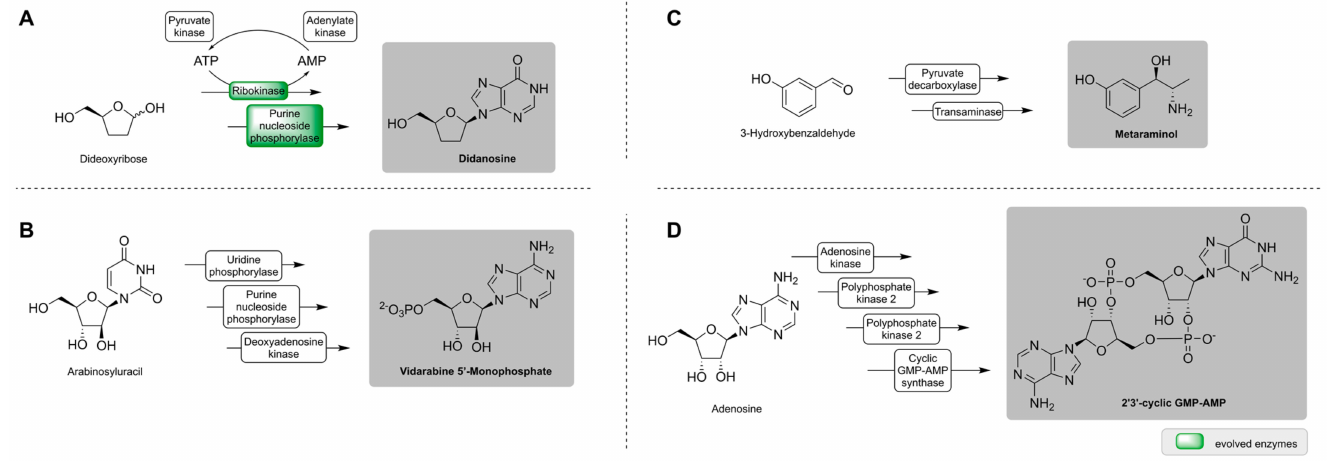
Figure 2. Shortened reactions of the enzyme cascades to produce didanosine ( A ) [57], vidarabine 5 (cid:48) -monophosphate ( B ) [58], metaraminol ( C ) [59], and 2 (cid:48) 3 (cid:48) -cyclic GMP-AMP ( D )